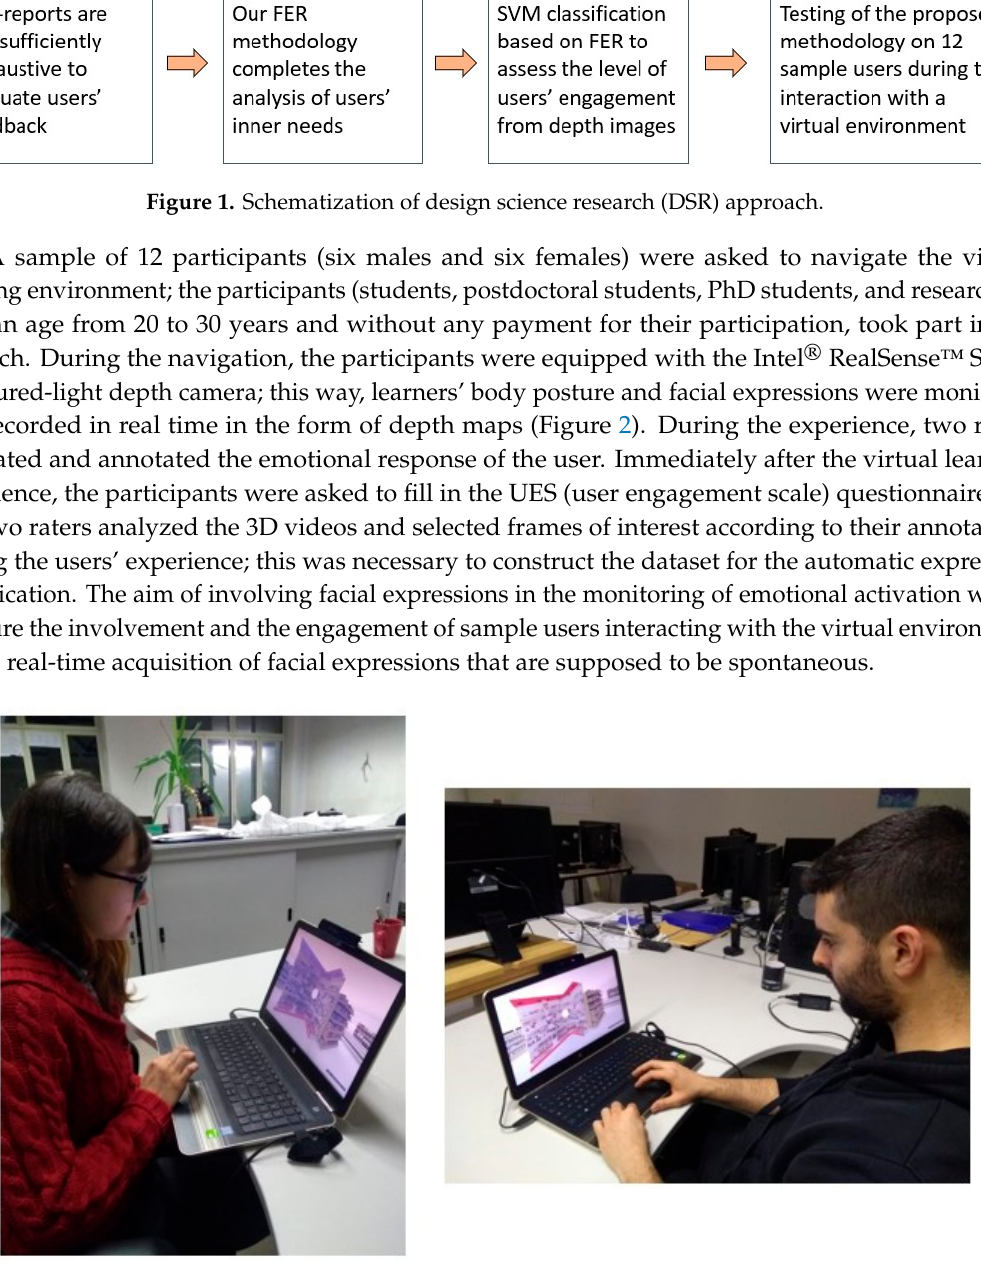
Figure 2. Example of experimental set-up.